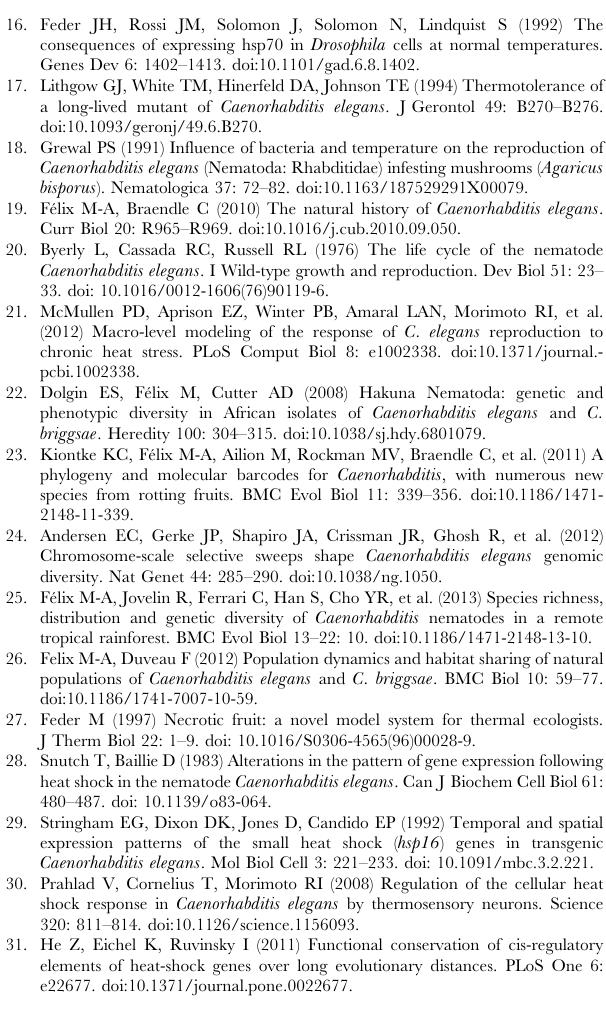
Figure S15 Timing of three milestones in the develop- ment of young adult hermaphrodites at 20 u C. Fraction of worms that have (A) produced the first oocyte, (B) begun to ovulate and produced the first embryo in the uterus. At each time point, multiple worms were observed. Fractions, not timing of events in individual animals are shown because once observed, animals could not be easily recovered. In contrast, (C) shows timing of first egg lay among 100 individually tracked worms. Table S1 Summary of results on recovery after heat stress. Table S2 Primary data from heat stress and recovery experiments. Table S3 Mutants of the inositol 1,4,5-trisphosphate Ca 2 + signaling pathway. Table S4 Developmental staging of ovulation mutants. The age at temperature shift reflects the degree that pleiotropic effects of mutations delayed development compared to wild type.